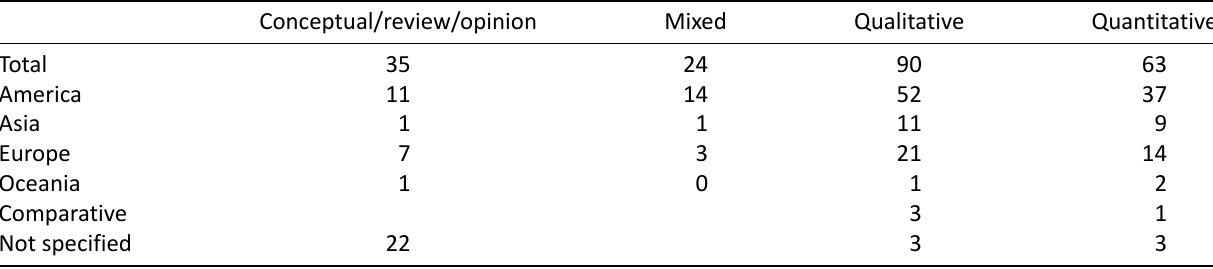
Table 2. Methodology of articles by geographical